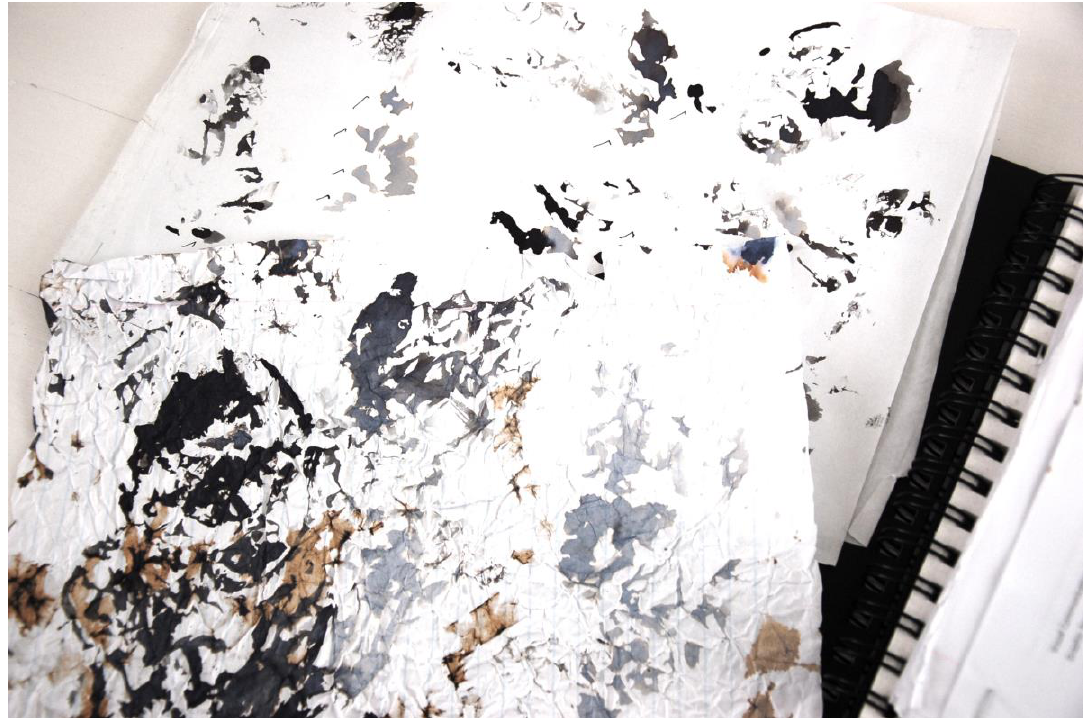
Figure 1.4 : Project 2: Process development (directed visual exploration and mark making exercises with paper folding) (Source: Kim,